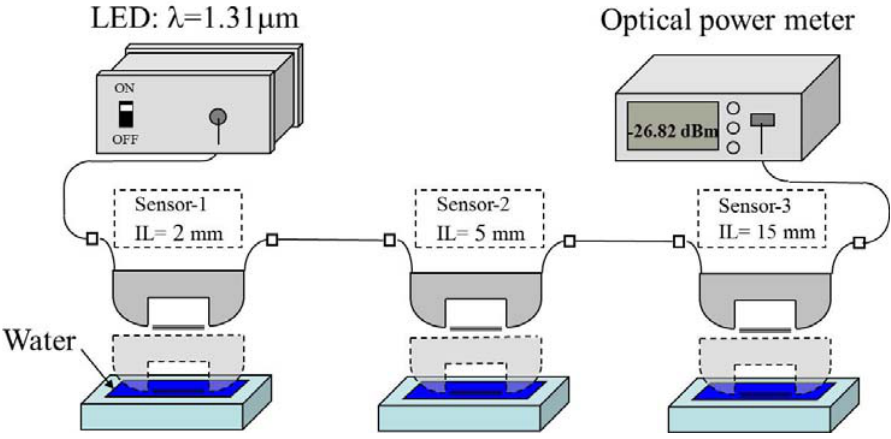
Figure 5. Experimental setup for multi-point liquid detection